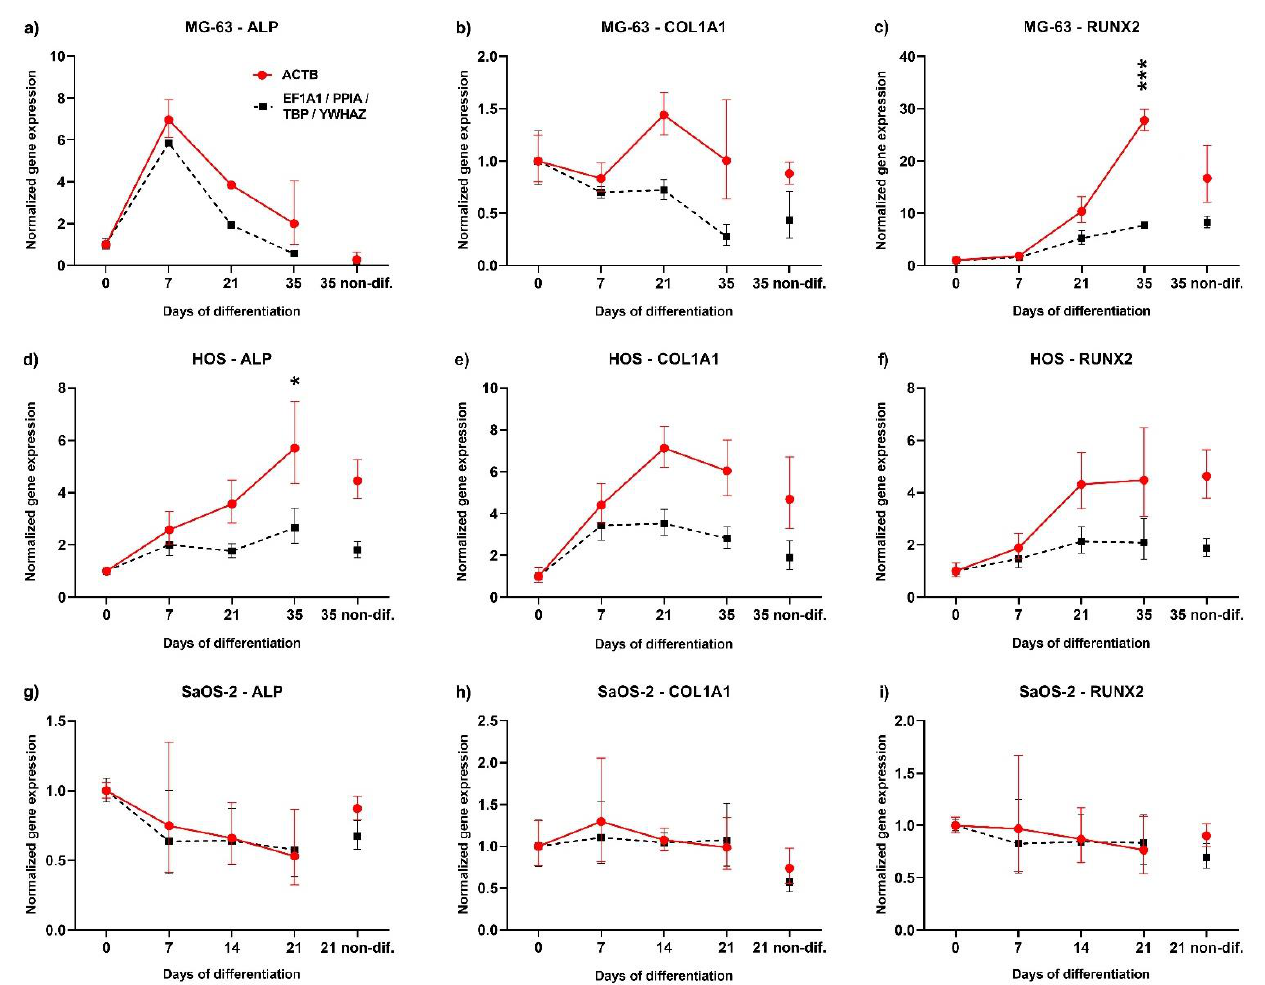
Figure 4. The choice of reference gene can impact obtained gene expression. MG-63 ( a – c ), HOS ( d – f ), and SaOS-2 ( g – i ) cell lines were differentiated and expression of ALP (Alkaline Phosphatase) ( a , d , g ), COL1A1 (Collagen type I alpha 1 chain) ( b , e , h ), and RUNX2 (Runt-related transcription factor 2) ( c , f , i ) differentiation markers was analysed at given time points using RT-qPCR. The relative quantity of each marker gene was normalized to ACTB (red) or to geometric mean of TBP , PPIA , YWHAZ , and EF1A1 (black) internal control genes. Results represent the mean and standard error of relative expression for three independent experiments. Statistical differences between the two normalizations were analysed using two-way ANOVA and are denoted as * p ≤ 0.05 and *** p ≤ 0.001.